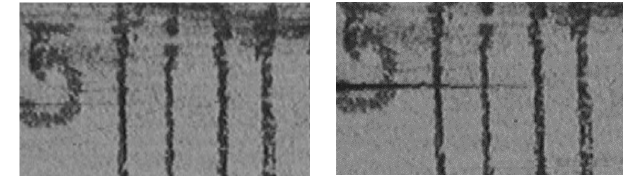
Figure 4. Different positions of the crack tip.